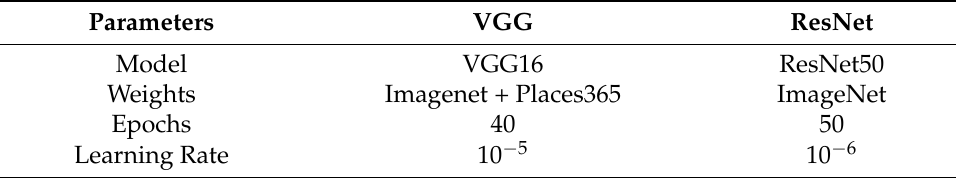
Table 1. Details of CNN-architectures utilized in